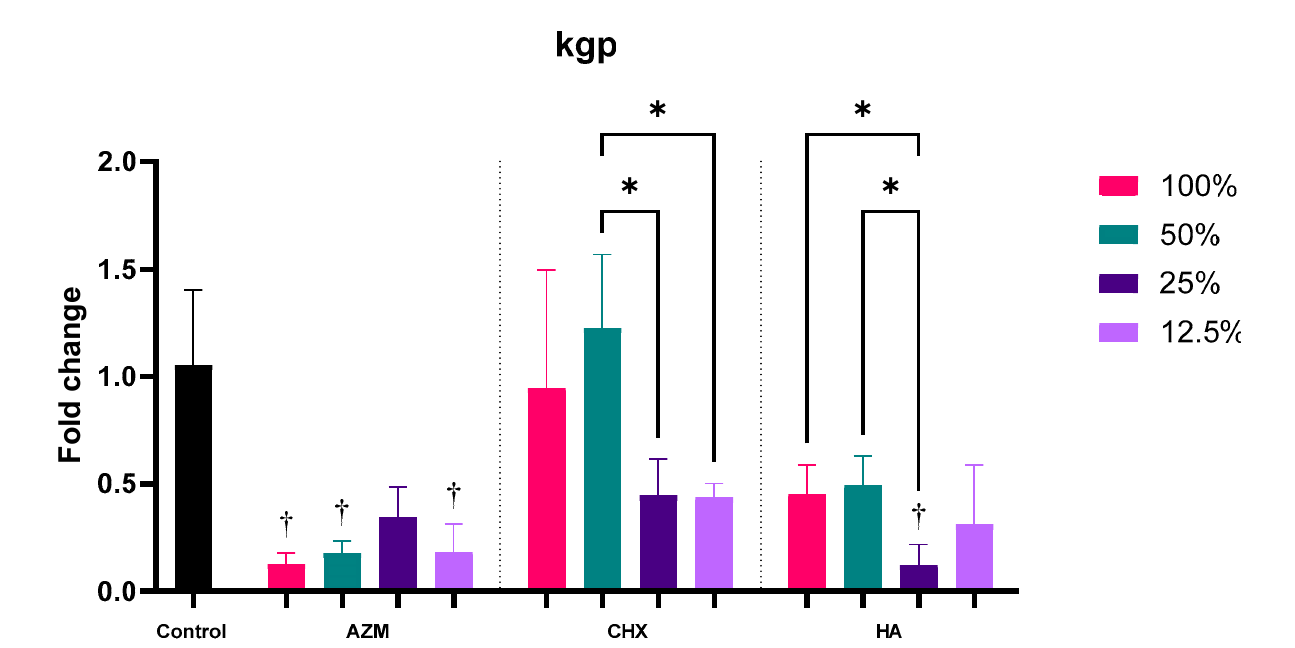
Figure 9. Fold-change values (mean ± SD) of different concentrations on expression of kgp. >0.05 (ns), ≤ 0.05 (*), ≤ 0.01 (**), ≤ 0.001 (***), ≤ 0.0001 (****). Statistically significant compared to control p < 0.05 (†).